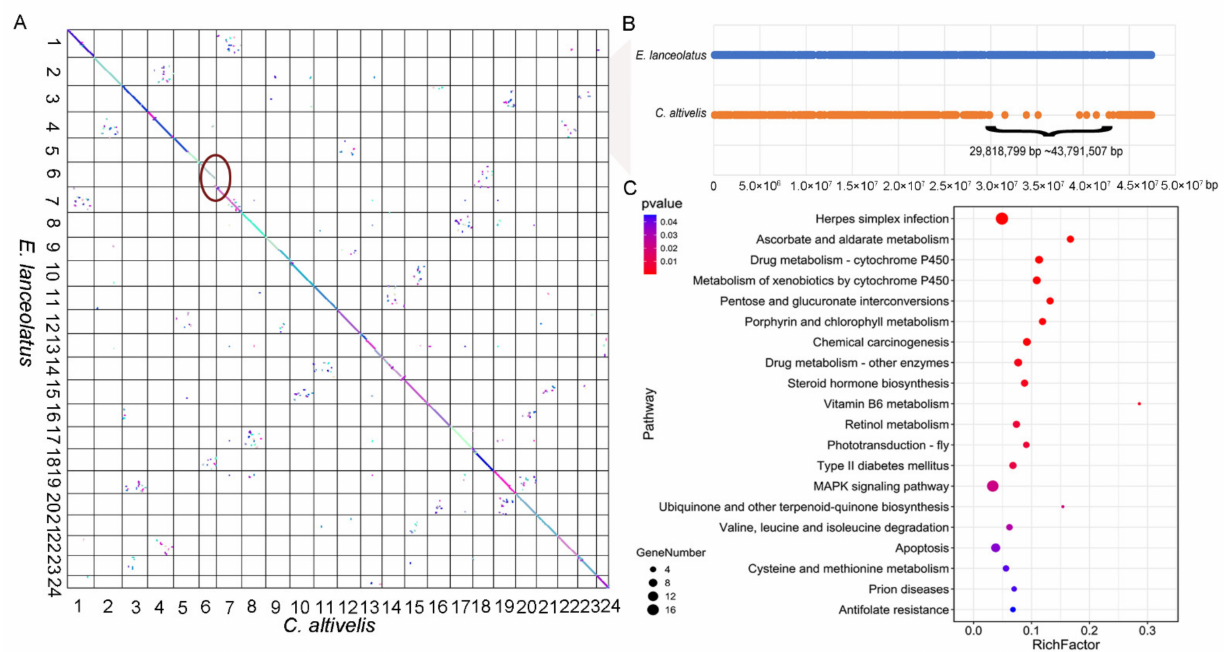
Figure 4. Collinearity analysis between humpback grouper and giant grouper. ( A ) Scatterplot of collinearity between humpback grouper and giant grouper, red circle showed the missing fragment in chromosome 6 of humpback grouper genome; ( B ) The distribution of genes in chromosome 6 of giant grouper and humpback grouper, multiple genes located in located in 29,818,799~43,791,507 bp of chromosome 6 were missed. ( C ) The KEGG enrichment analysis of missed